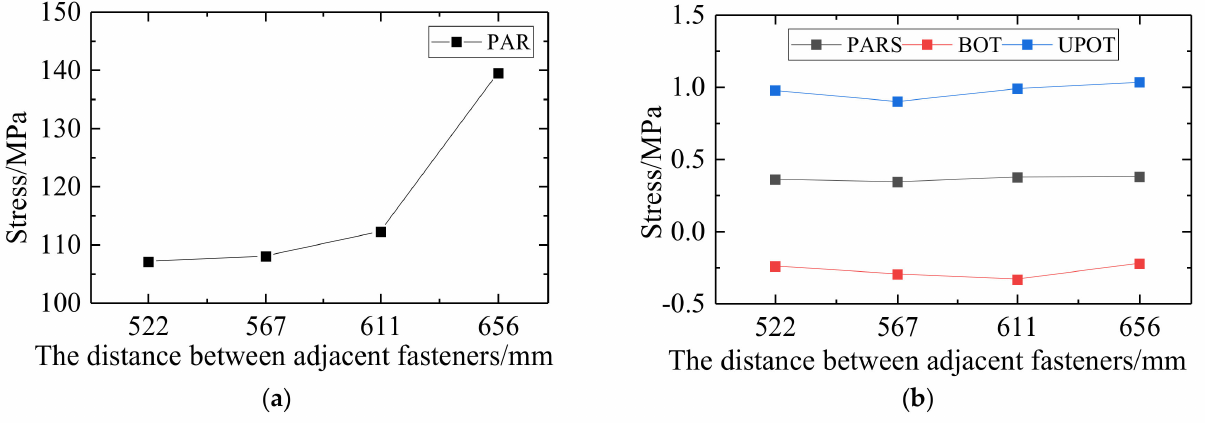
Figure 27. Stress change curve of NFTBT’s structure under different distance between adjacent fasteners: ( a ) Rail stress; ( b ) Track structure